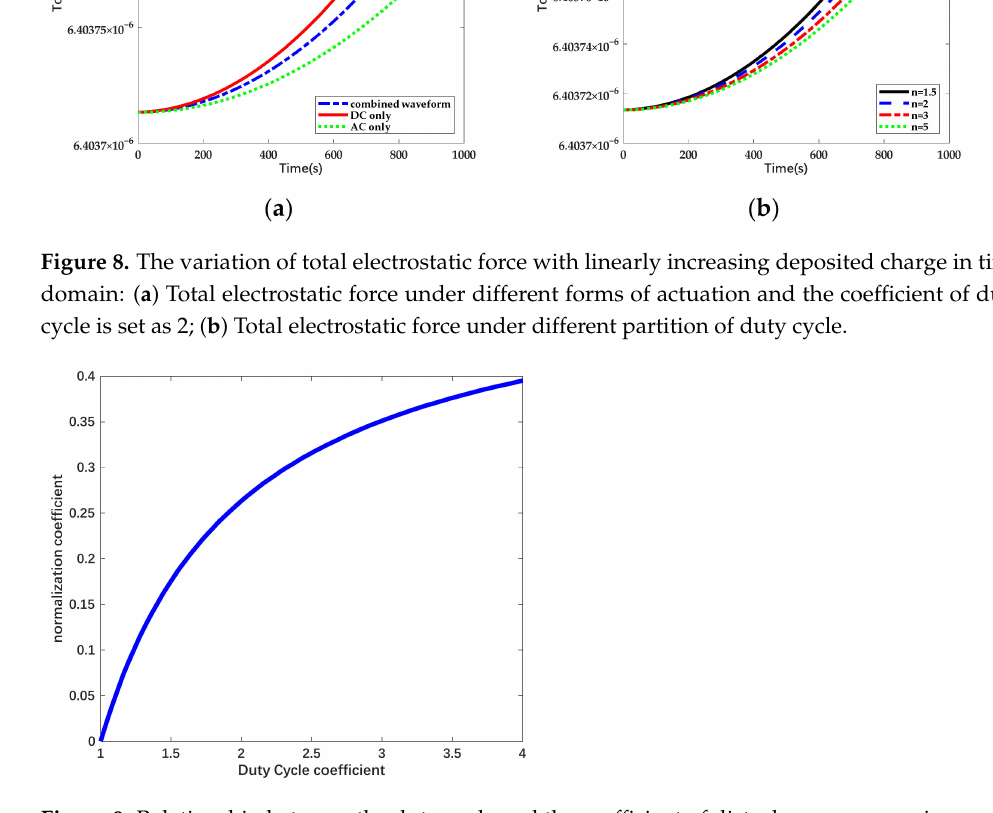
Figure 9. Relationship between the duty cycle and the coefficient of disturbance